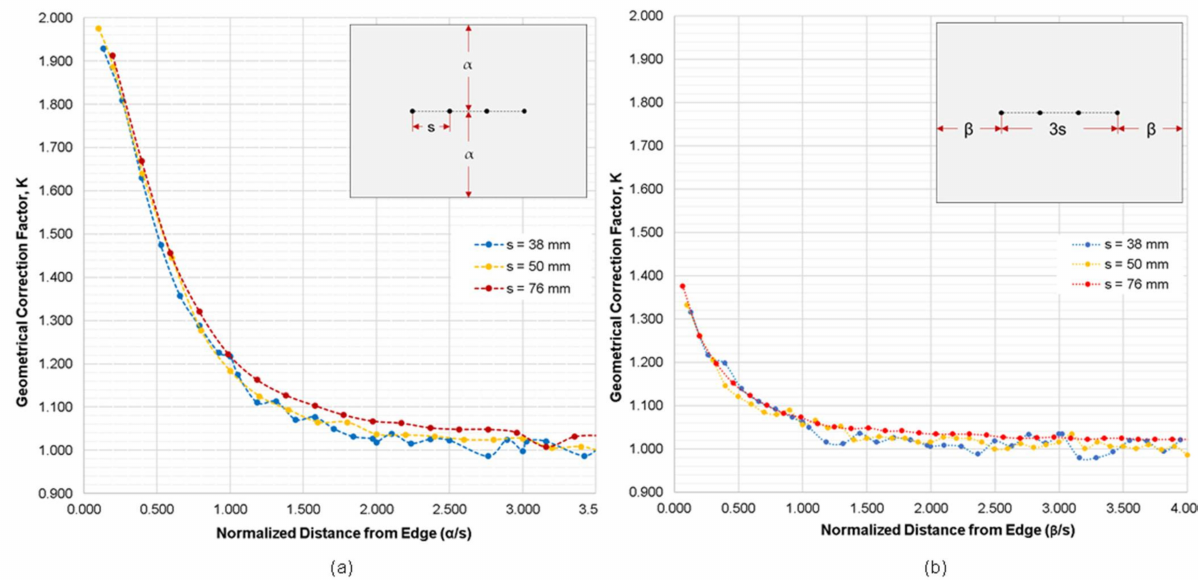
Figure 6. Variation of geometrical correction factor, K , obtained from the numerical simulation cases 2 and 3, with respect to the normalized distance from slab edge where ( a ) probes are parallel to the edge of slab, and ( b ) probes are perpendicular to the slab